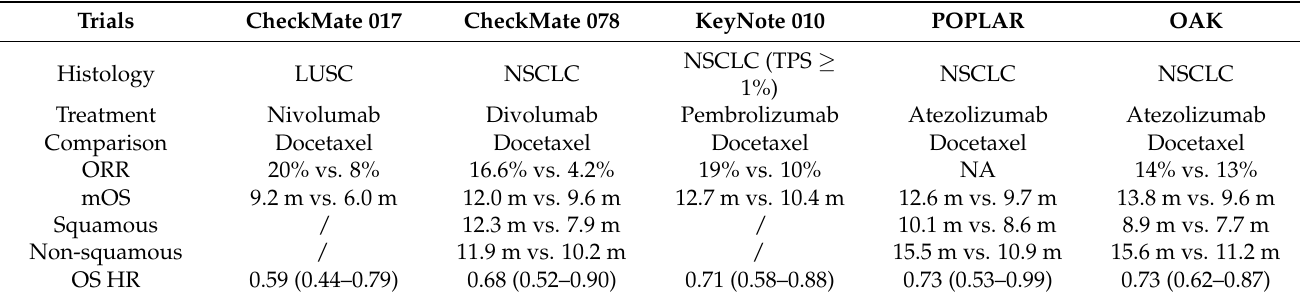
Table 2. The second-line clinical trials of anti-PD-1/PD-L1 in metastatic